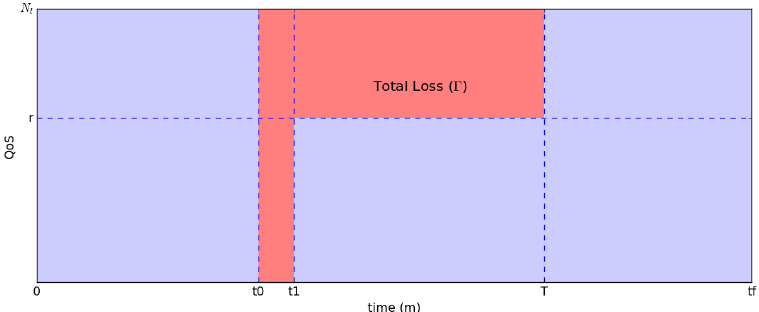
Figure 4. The total loss area related to a perturbed MV line.